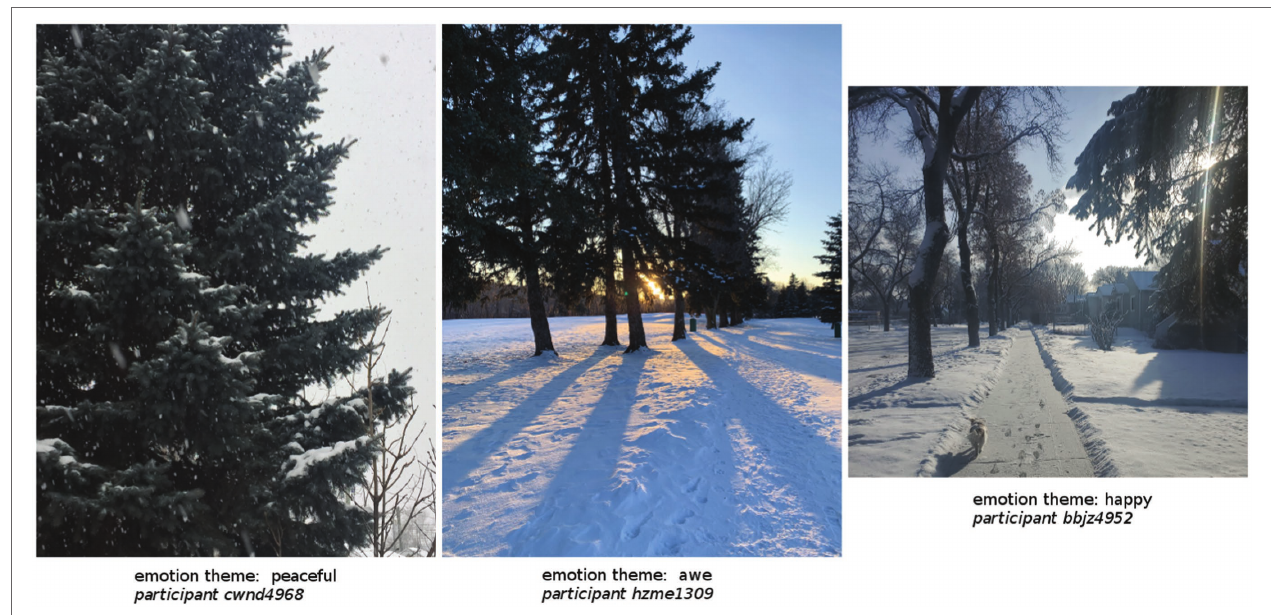
FIGURE 4 | Selection of photos as illustrative sample of the top three emotion themes most likely to be associated with nature